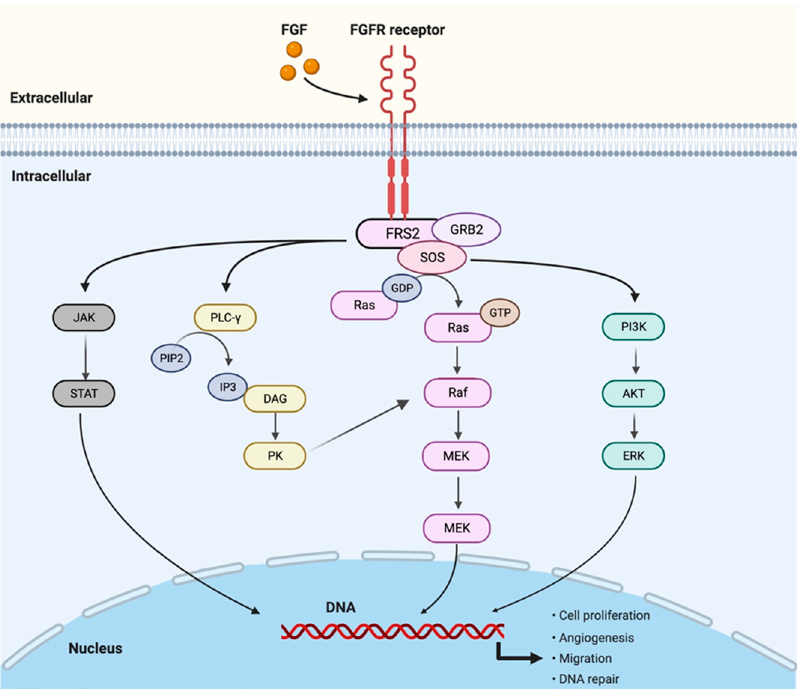
Figure 1. FGFR pathway: The FGFR dimerizes upon ligand (FGF) binding, activating the down- stream cascade of signaling pathways. The main pathways activated are the phosphorylation of the signal transducer and activator of transcription (STAT), the PLC γ activation of the DAG–PKC and IP3–Ca2+ cascade, resulting in DNA transcription, the mitogen-activated protein kinase (MAPK) pathway, and the phosphoinositide-3-kinase (PI3K/Akt) pathway. Figure created with BioRen- der.com.